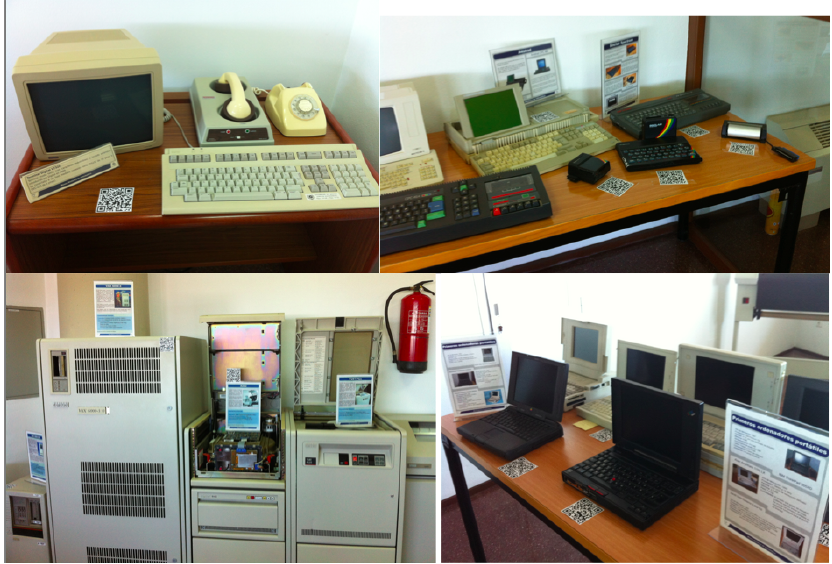
Figure 3. Snapshots of Type 2 room in the Museum of